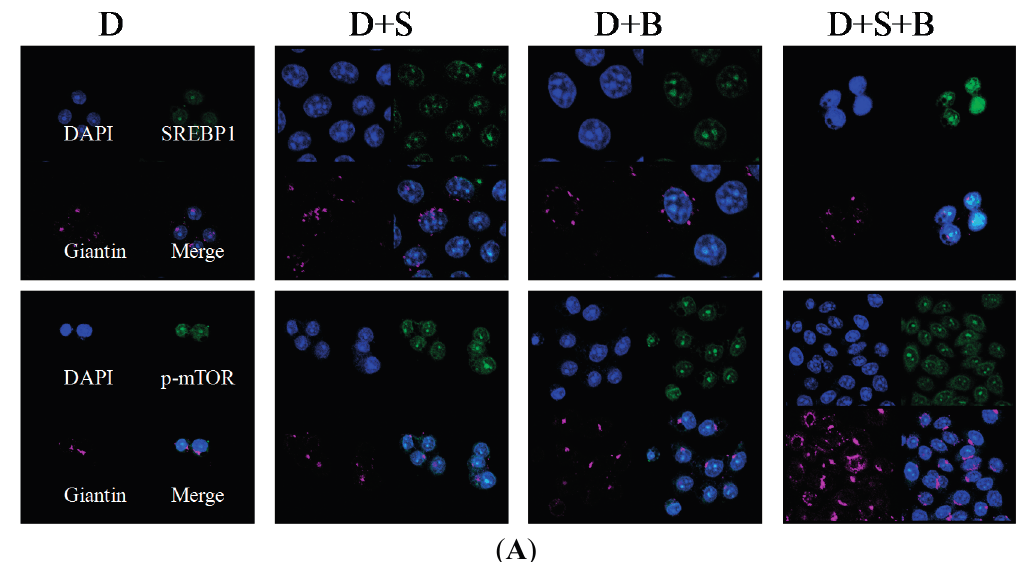
Figure 5. The effect of stearic acid and serum on the subcellular localization of molecules related to milk fat synthesis. Groups of DCMECs were assessed as in Figure 4. ( A ) Localization of SREBP1 and p-mTOR. SREBP1 (green), giantin (purple), and DAPI (dark blue). Scale bars = 10 μ m; ( B ) Integral optical density analysis of p-mTOR. p-mTOR (green), giantin (purple), and DAPI (blue). Scale bars = 10 μ m; and ( C , D ) Immunofluorescent staining and integral optical density analysis of lipid droplets. Lipid droplet (green) and DAPI (blue). Scale bars = 10, 15, 45 or 60 μ m. Values represent means ± SE ( n = 3). ** p < 0.01 compared with negative control